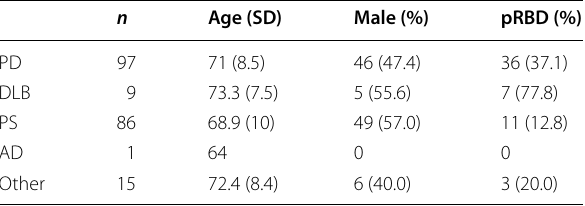
Table 2 Demographics of the 208 patients subjected to pharmacokinetic analysis